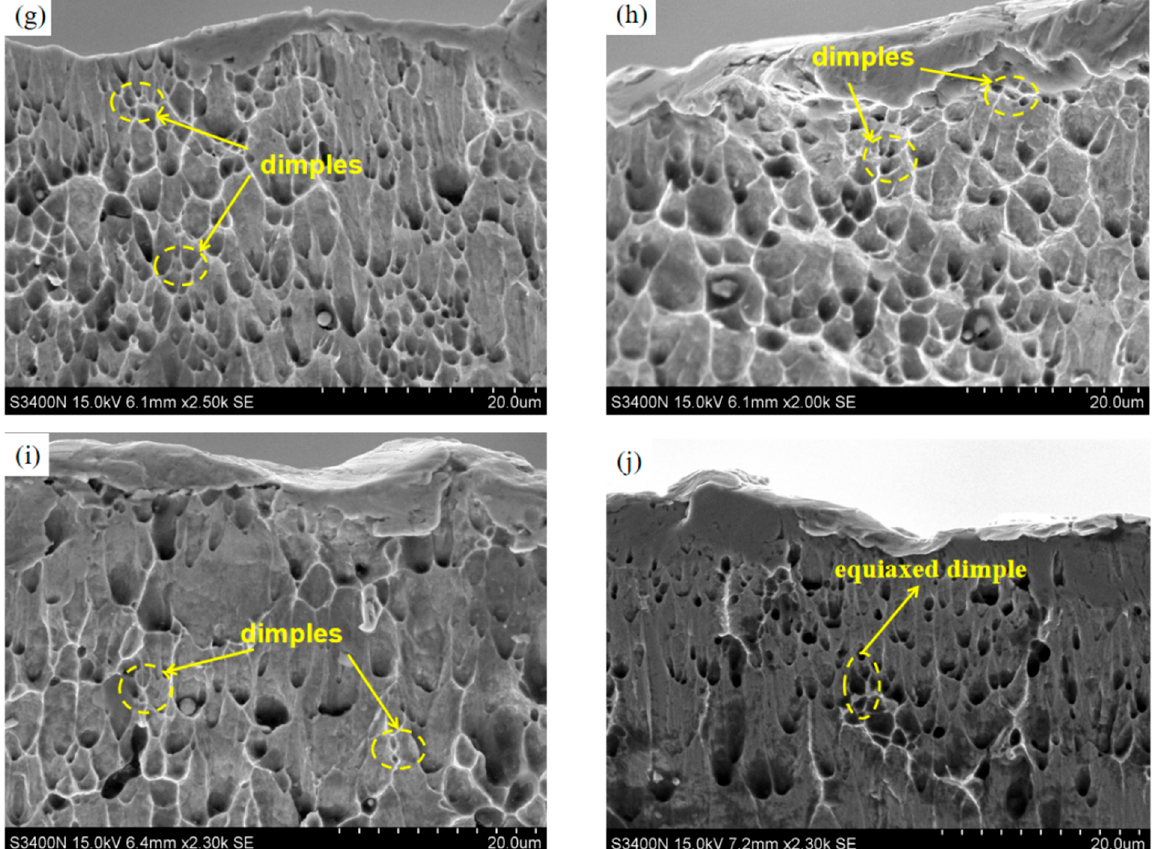
Figure 8. The fracture microscopic morphology of the sample after 2000 times magnification. ( a ) Sample no. 1; ( b ) sample no. 2; ( c ) sample no. 3; ( d ) sample no. 4; ( e ) sample no. 5; ( f ) sample no. 6; ( g ) sample no. 7; ( h ) sample no. 8; ( i ) sample no. 9; ( j ) sample no. 10.